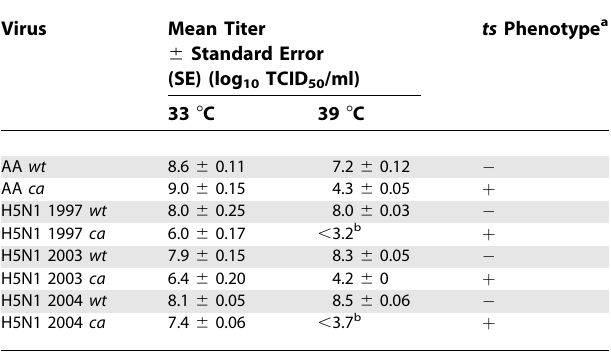
Table 2. Evaluation of the ts Phenotype of Wild-Type and Reassortant H5N1 ca Influenza